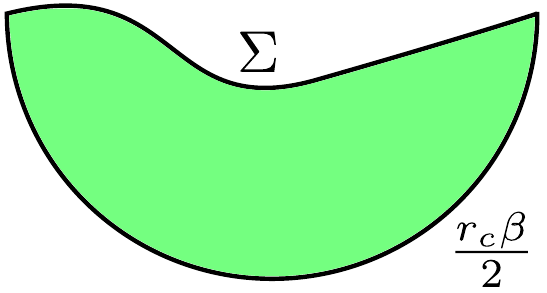
Figure 5 . The Hartle-Hawking state: we sum over geometries and dilaton con(cid:12)gurations with an AdS boundary of length r c (cid:12)= 2 and a \bulk" boundary (cid:6), which we interpret as a time-slice of the two-boundary system. The boundary conditions on (cid:6) depend on which basis we wish to compute the wave function